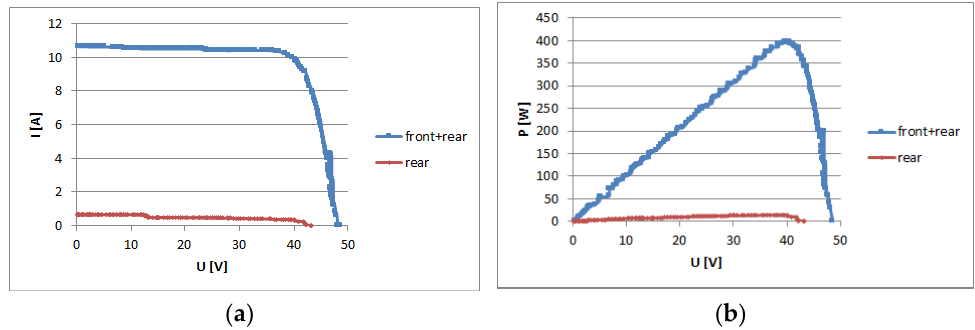
Table 16. The measurements results and calculations for 60° inclination of the module over the white substrate, considering the values for the whole-module generation and its rear side generation.